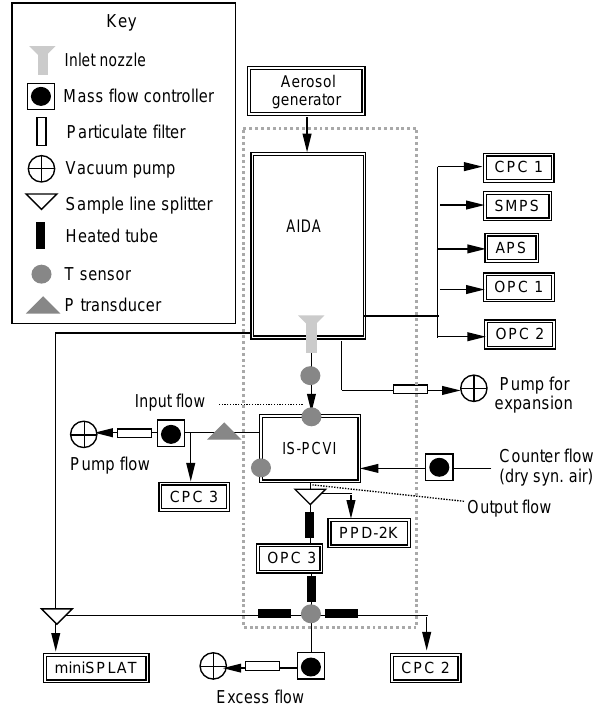
Figure 3. Schematic representation of the experimental setup for validation of the IS-PCVI. The grey dashed line represents the heat- insulating wall of AIDA. Different types of aerosol generators used in this work are summarized in Table S1 in the